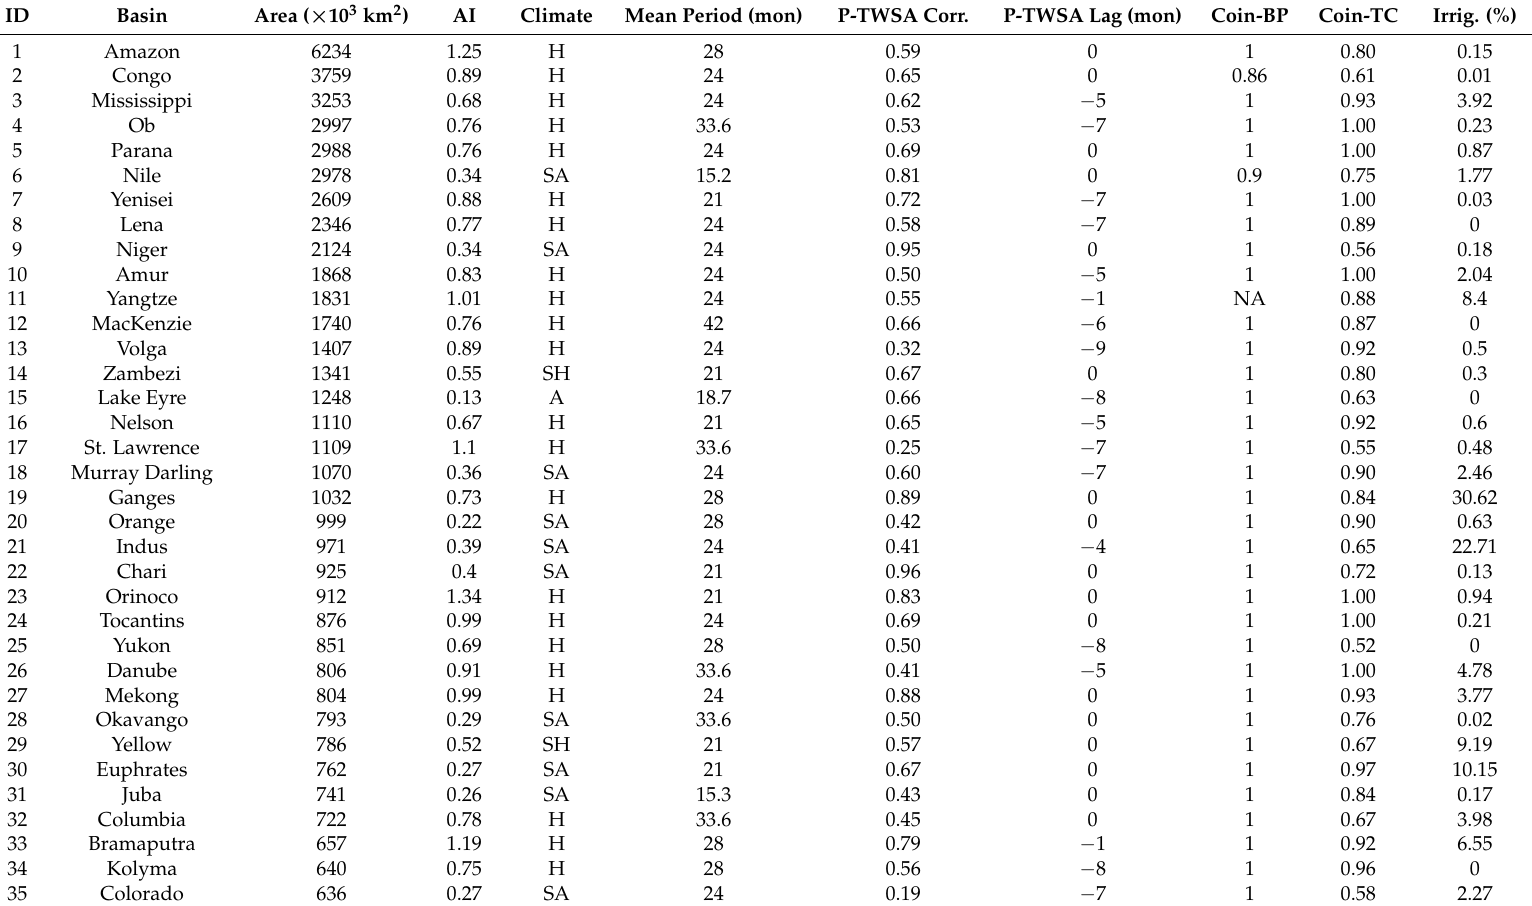
Table 1. List of 35 global basins examined in this study. AI represents aridity index, CoinBP and CoinTC represent event coincidence rates calculated using BP and TC methods, respectively, P-TWSA lag is in months. Under the Climate column: H-human, SH-semihumid, SA-semiarid, and A-arid. Irrigation area is given as percentage of basin